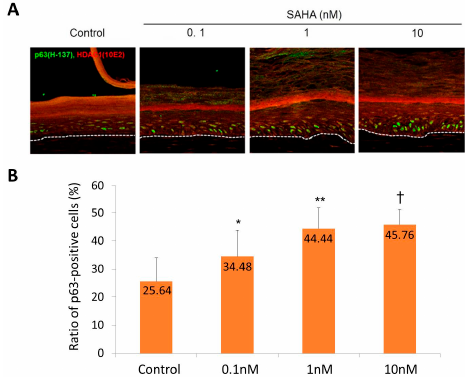
Figure 4. The p63 and HDAC1 staining in skin equivalents, ( A ) Confocal microscopic examination in SAHA treated samples (green; p63 staining, red; HDAC1 staining, ×200); ( B ) The ratio of epidermal cells with p63-positive staining in SAHA treated samples. Six circular areas were randomly selected and the percentage of p63-positive cells to total epidermal cells were calculated. Statistical significance was calculated with the Mann-Whitney- U test, * p < 0.05 compared with the control, ** p < 0.01 compared with the control, † p < 0.01 compared with the 0.1 nM. This experiment was repeated twice and representative areas are shown.